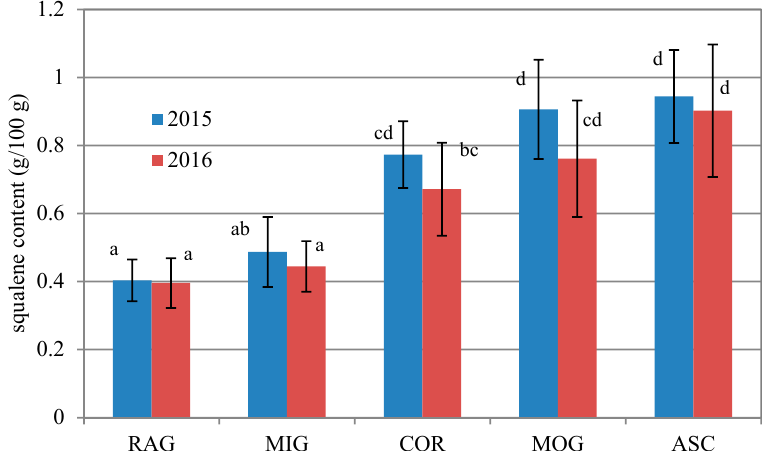
Figure 2. Average squalene content (g / 100 g) in Ascolana tenera (ASC), Coroncina (COR), Mignola (MIG), Piantone di Mogliano (MOG), and Raggia (RAG) monovarietal oils investigated were produced in 2015 and 2016. Bars indicate ± standard deviation. All different letters indicate significant differences ( p < 0.05, One-way ANOVA, Tukey’s test for pairwise comparison) among the 10 oil sample groups investigated.